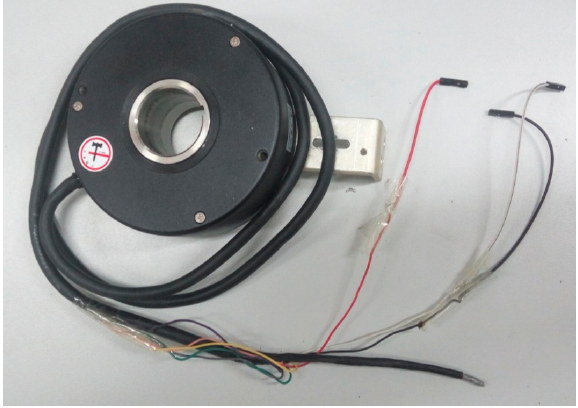
Figure 4. Image of the encoder.